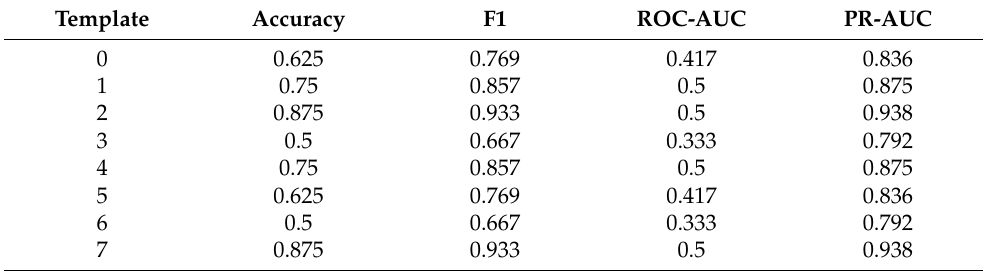
Table 5. Classification in eight test data of bipolar voltage on 1Y re AF through LOOCV.